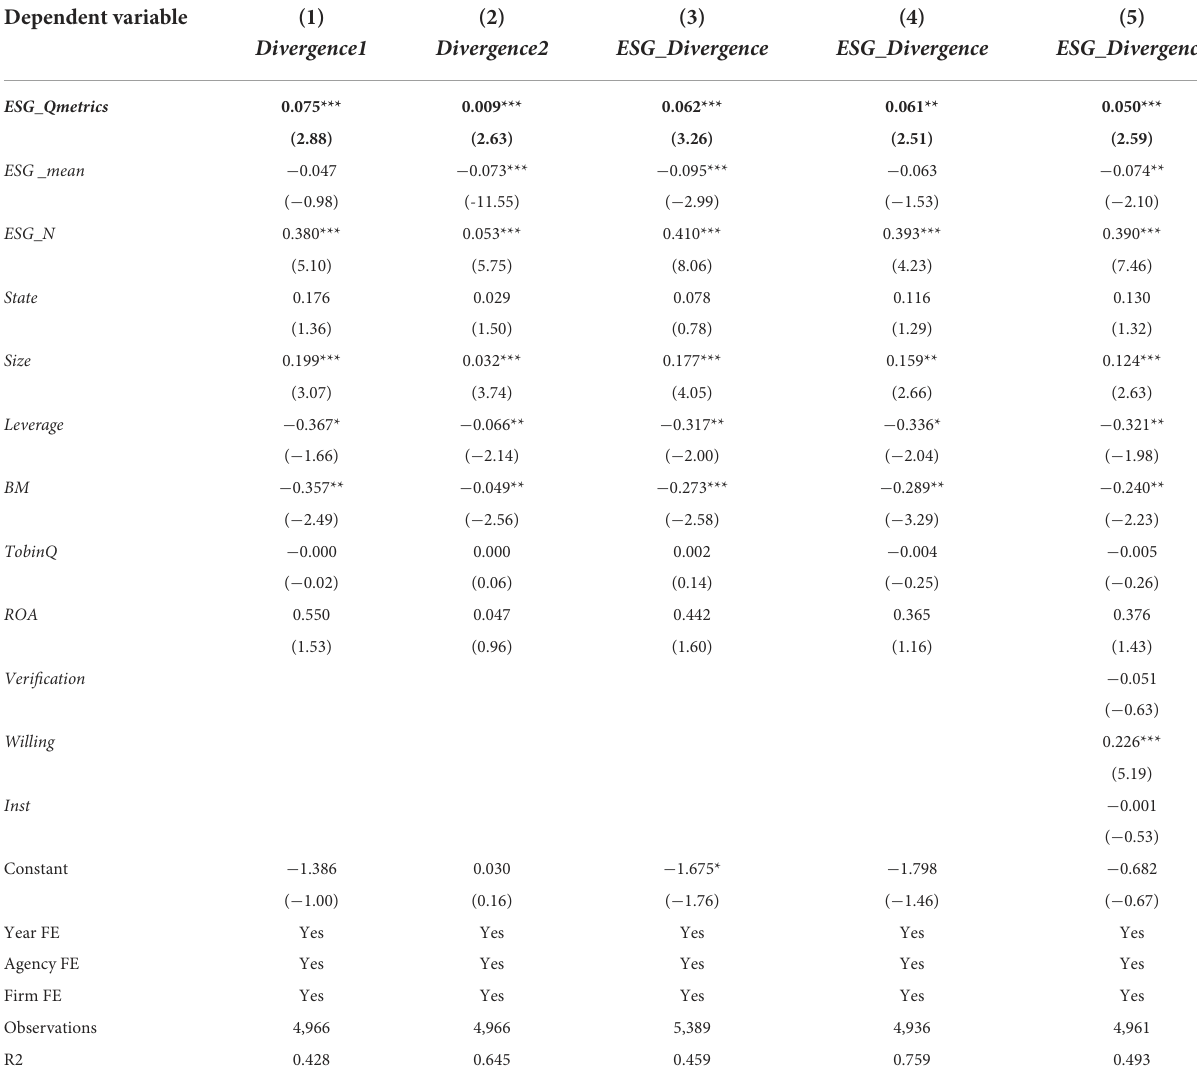
TABLE 8 Robustness checks: using alternative measures, alternative sample, and alternative